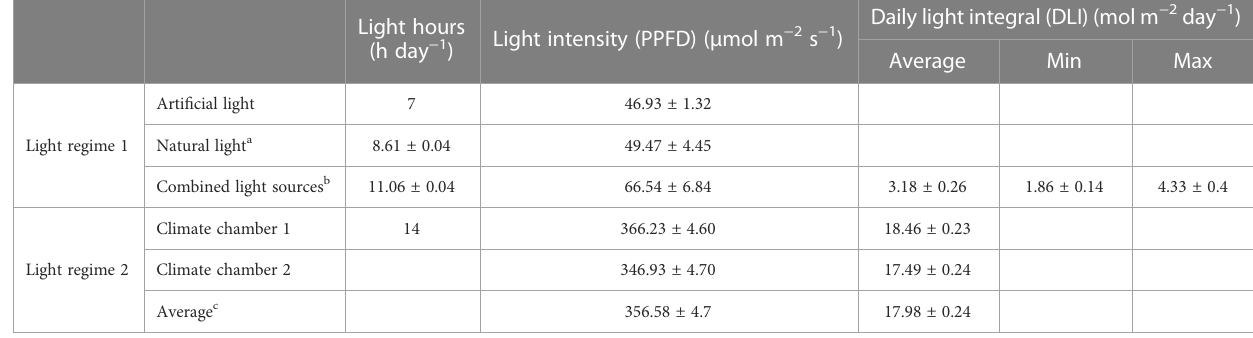
TABLE 1 Light settings of light regime 1 (LR1, greenhouse) and light regime 2 (LR2, indoor farming) (means ±